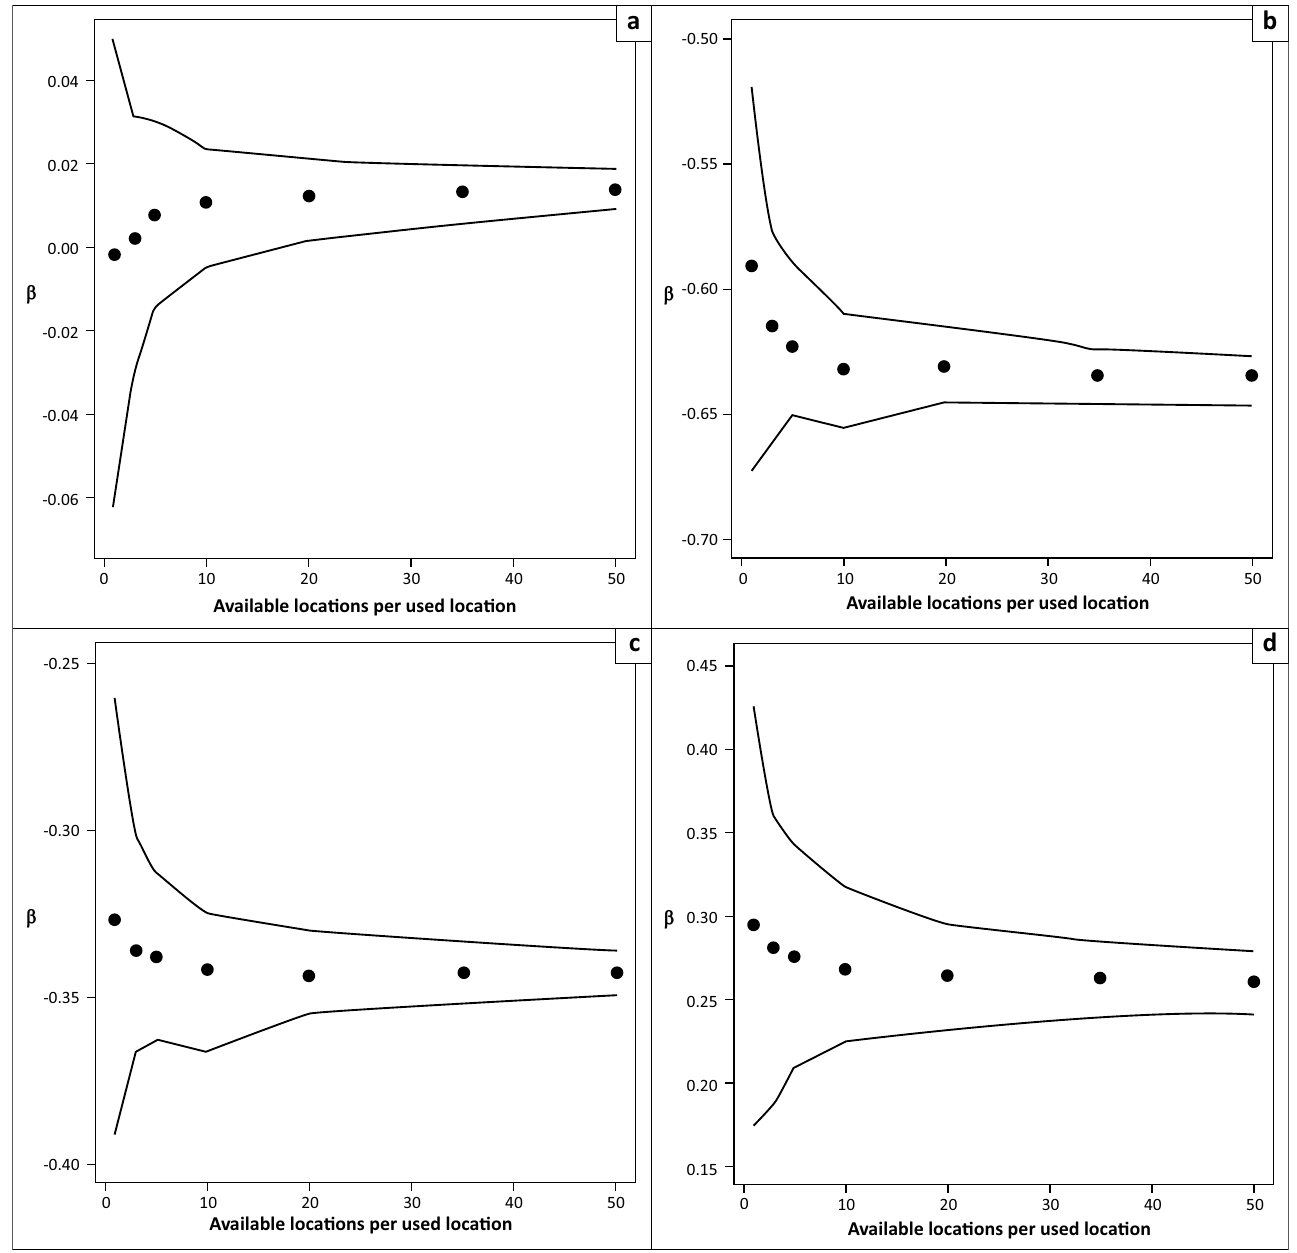
FIGURE 3-A3: Coefficient estimates (black points) and 95 % simulation envelopes (solid lines) for (a) Normalised Difference Vegetation Index, (b) distance to water, (c) slope and (d) terrain ruggedness, calculated from 100 conditional logistic regression models fit to varying ratios of available to used elephant locations recorded at